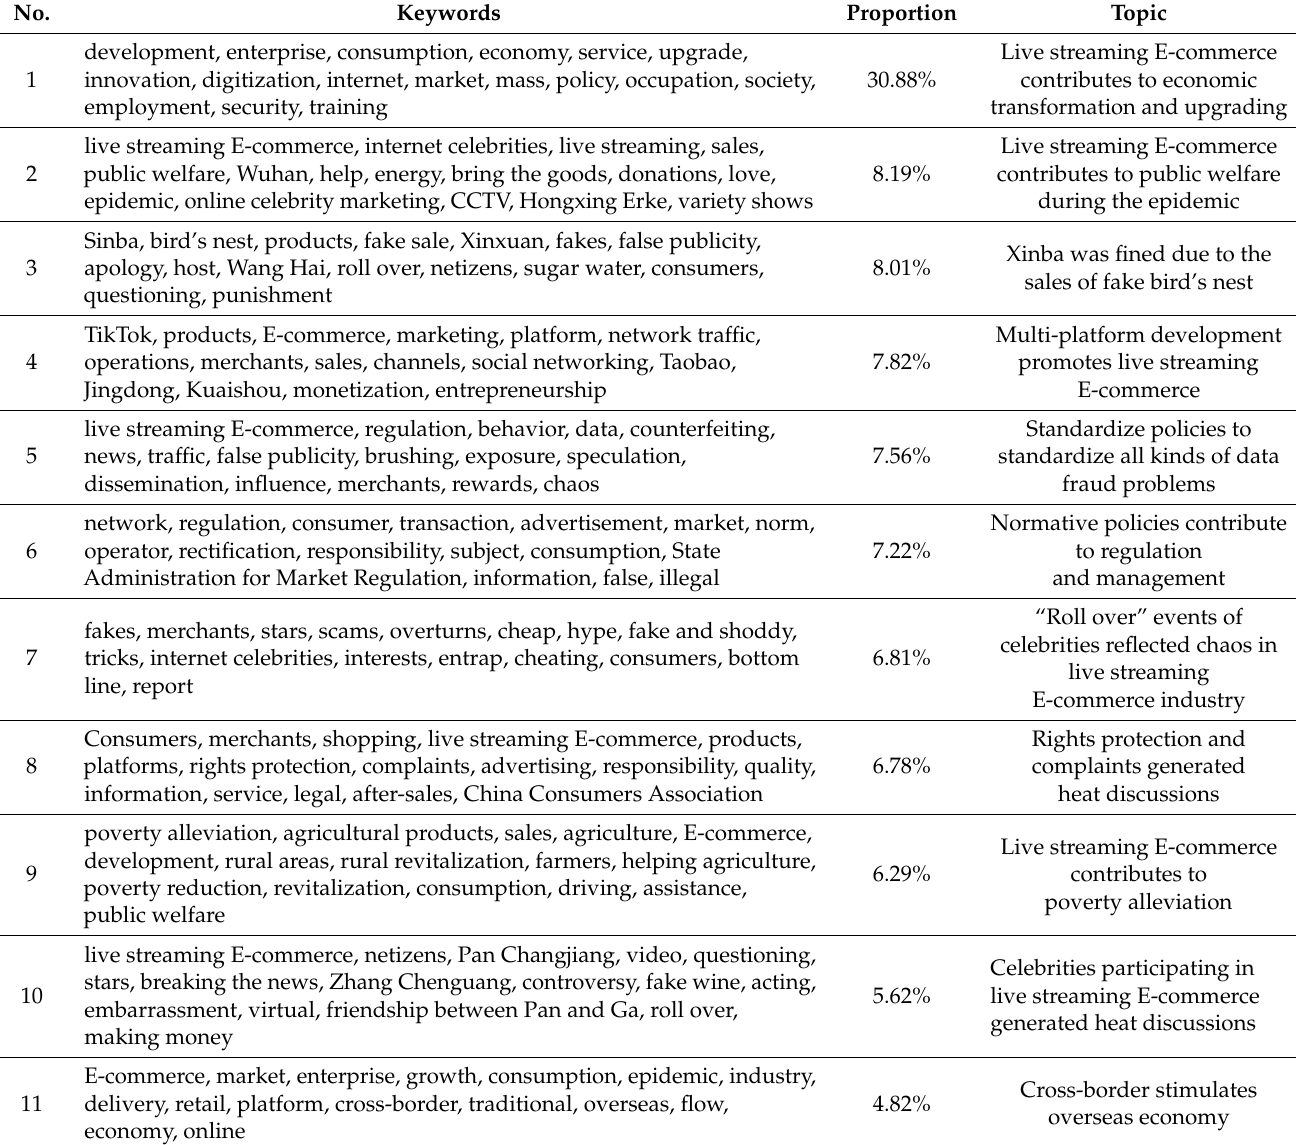
Table 7. LDA models after policy implementation.